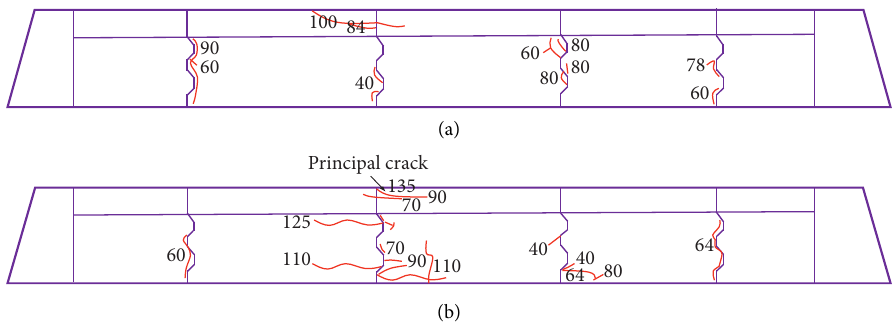
Figure 10: Crack distributions of specimen 1: (a) front profile; (b) back